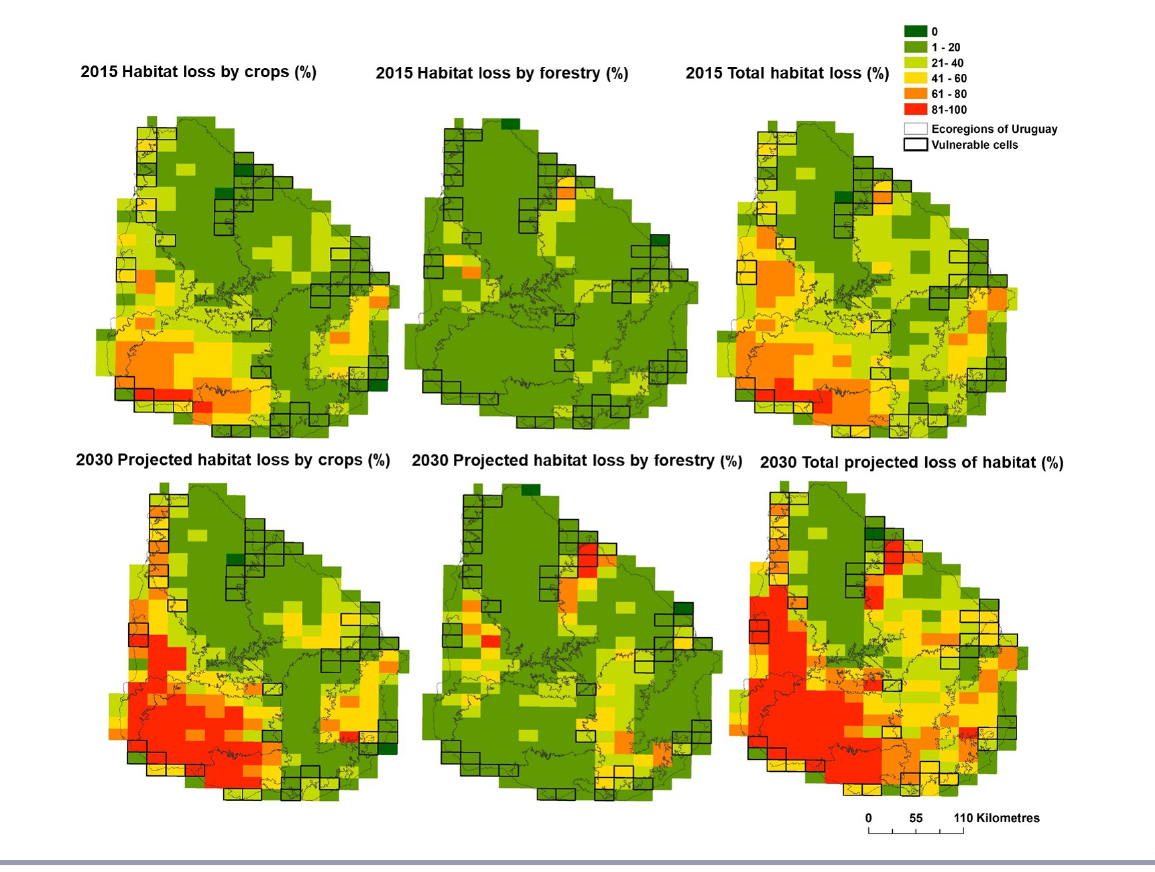
Fig. 4 . Original habitat loss by land-use changes in 2015, and projected loss in the 2030 scenario because of soybean and exotic forests expansions. The highest (i.e., top 17%) vulnerable cells for conserving the vertebrate and woody plant diversity per each ecoregion are